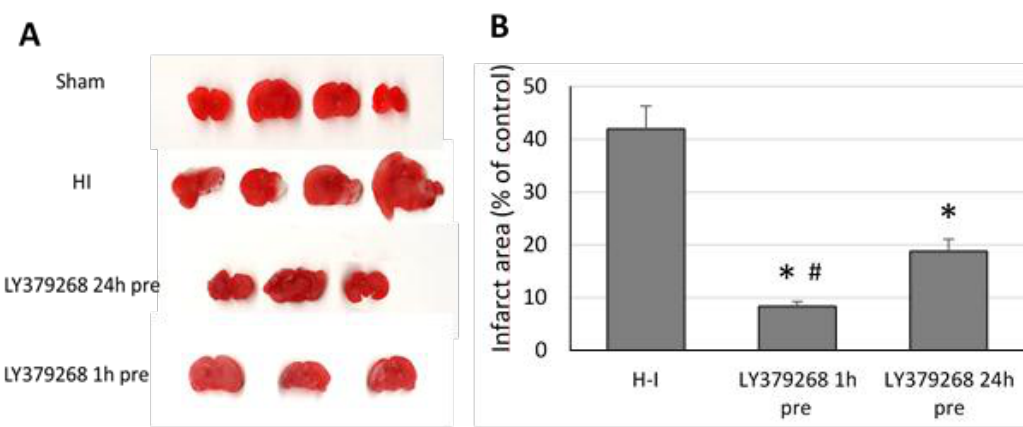
Figure 1. ( a ) Application of LY379268 before hypoxia-ischemia (H-I) reduces the infarct area in the ipsilateral hemisphere. Representative photomicrographs of TTC staining of the infarct areas in the brains of rats. ( b ) Quantification of the infarct area after H-I revealed by TTC staining. Number of animals per group n = 4–5. Results are presented as the mean values ± SD, * p < 0.001—significantly different from the H-I group; #—significantly different from the group injected 24 h before H-I. The brains were analysed 7 days after H-I.